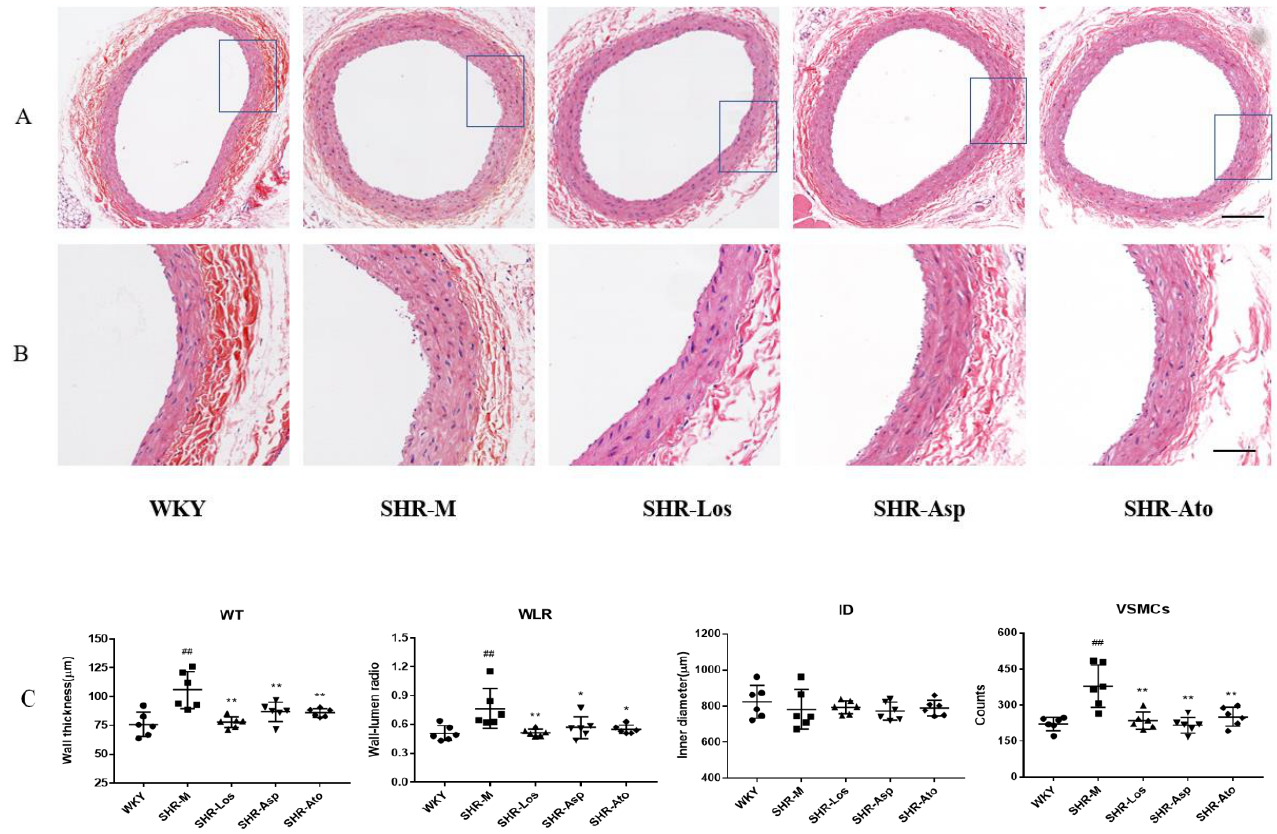
Figure 2. The histological morphological changes in carotid aorta in each group (22 weeks rats). ( A ) H&E stain in cross section of carotid aortas. (scale bar = 200 µ m); ( B ) magnified images of A (scale bar = 100 µ m); ( C ) wall thickness (WT), wall-to-lumen ratio (WLR), inner diameter (ID), and number of VSMCs (VSMC) in tunica media, respectively. The data are presented as the mean ± SD. n = 6, ## p < 0.01 vs. WKY; * p < 0.05, ** p < 0.01 vs. SHR-M.